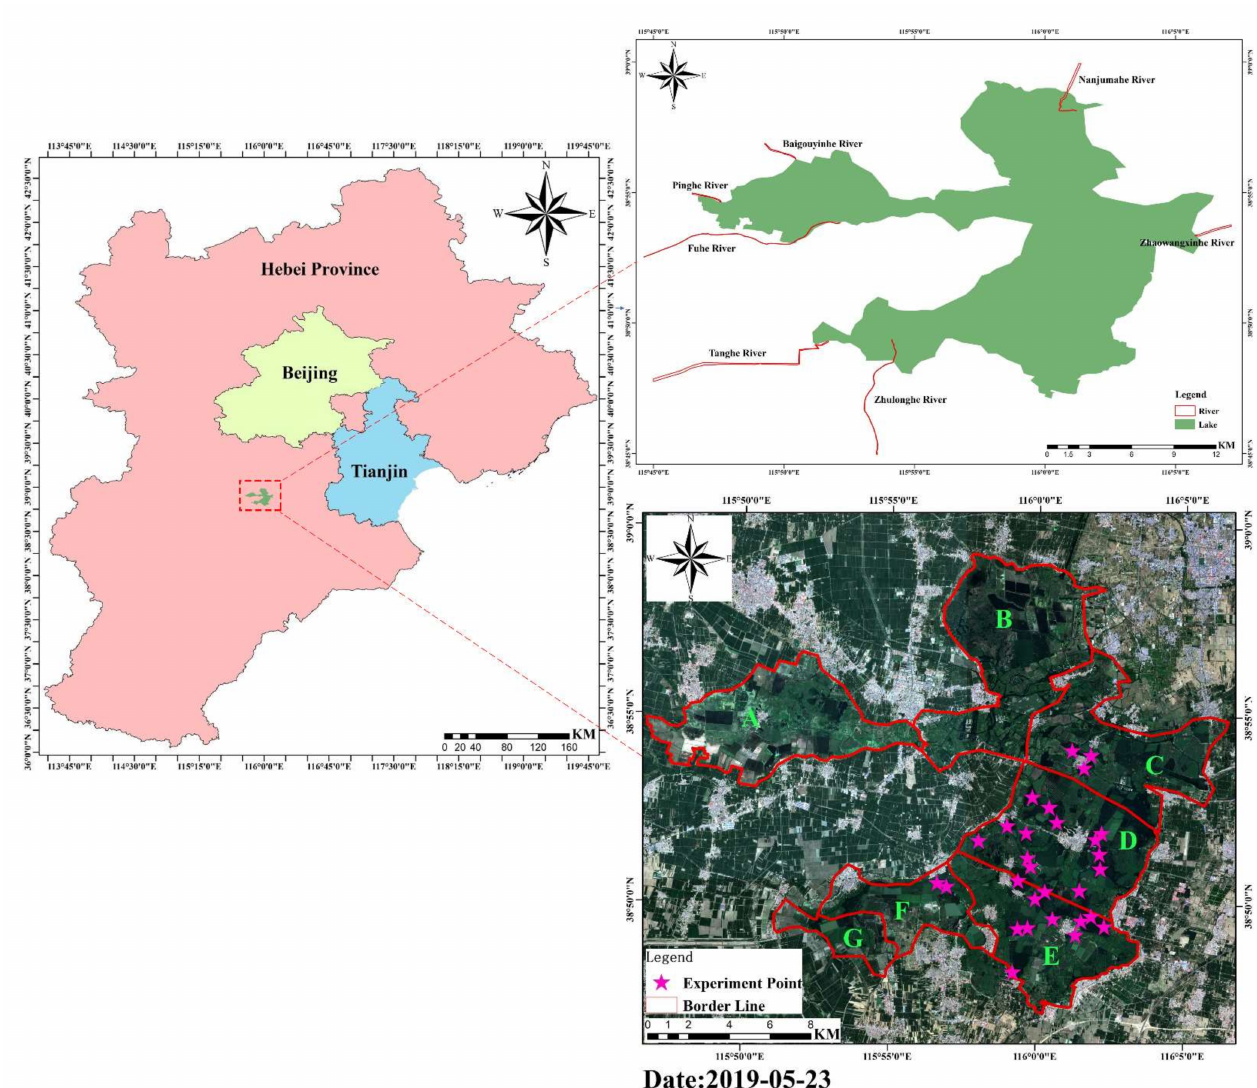
Figure 1. Study area at ( a ) Beijing-Tianjin-Hebei Province, ( b ) Baiyangdian Lake and surrounding rivers, and ( c ) seven sub-regions of and study sites at Baiyangdian